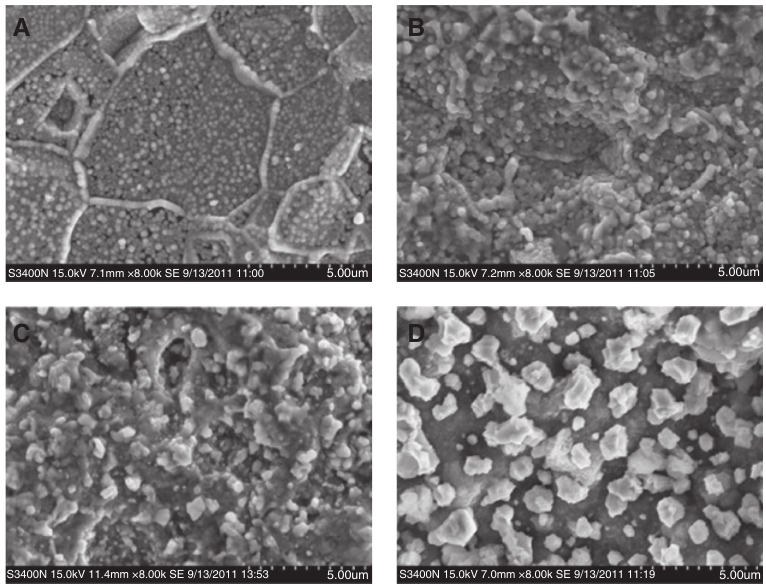
Figure 33: SEM photographs of 0.4 wt.% Pd/FeCrAl catalysts prepared at different calcination temperatures: (A) 400 ° C, (B) 600 ° C, (C) 800 ° C and (D) 1,000 ° C. Reproduced from [141] with permission from Elsevier